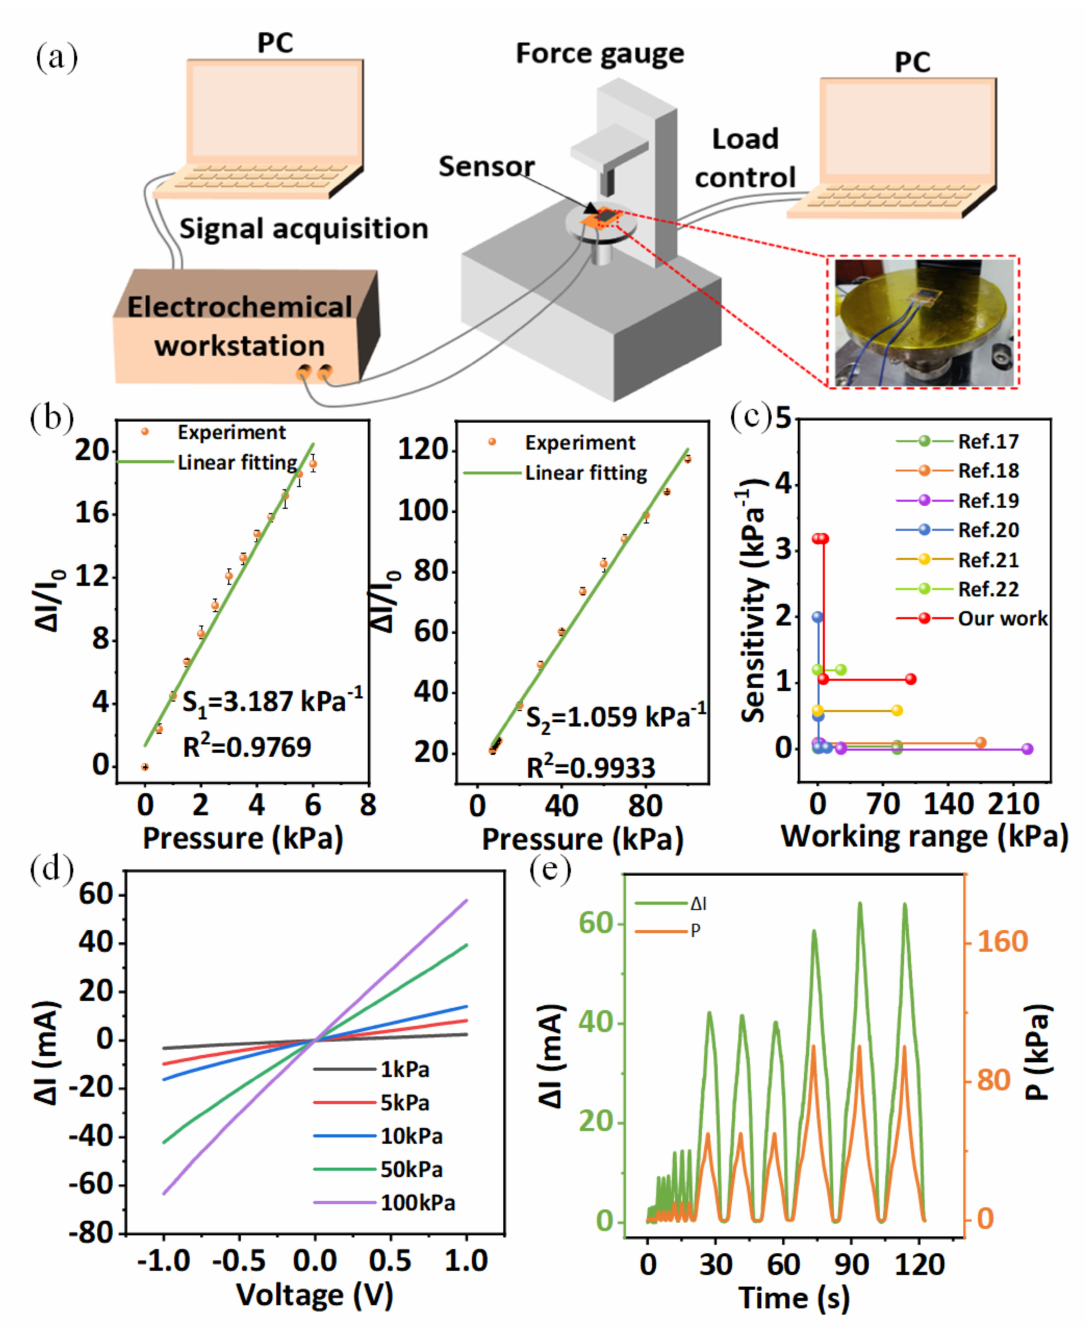
Figure 3. ( a ) Schematic illustration of the experimental setup; ( b ) the sensitivity of FPS, showing a high sensitivity of 3.187 kPa − 1 within 6 kPa and 1.059 kPa − 1 in a larger pressure region up to 100 kPa; ( c ) comparison of the fabricated sensor with other flexible sensors; ( d ) I–V curves of the sensor under various applied pressures; ( e ) current response under increasing